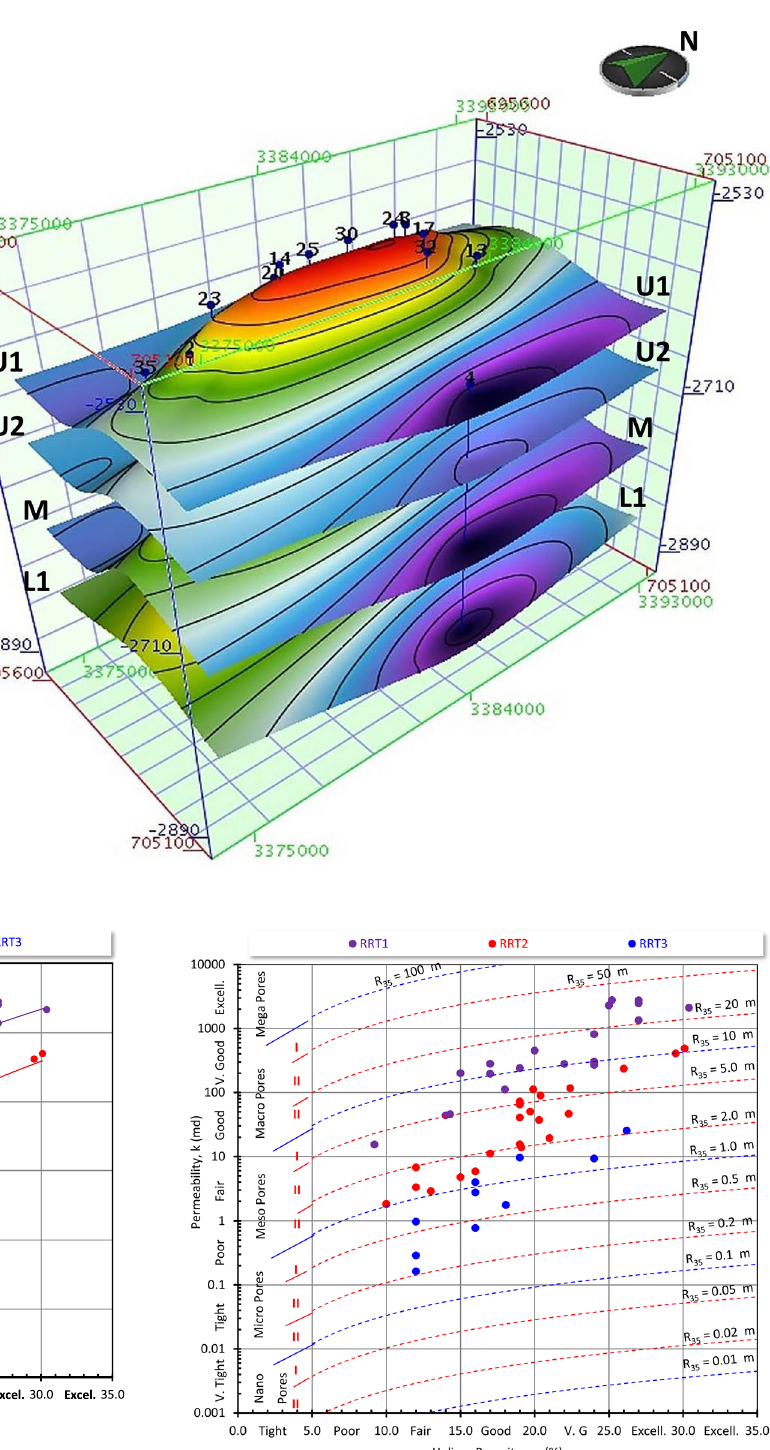
Fig. 15 Rock typing of the promising Albian sequence (M and L1 units) based on the porosity, permeability, and discrete rock type (DRT) values